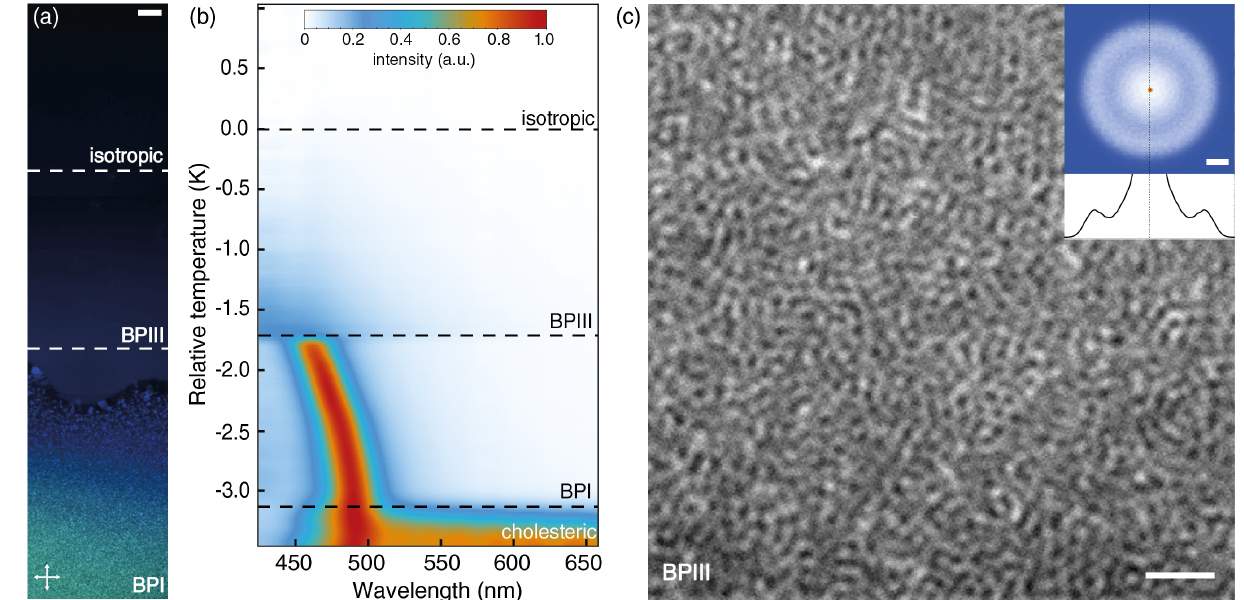
FIG. 4. Reflectivity and appearance of blue phase III of chiral liquid crystals. (a) Photograph of BPIII LC in a capillary with a large temperature gradient, from T ∼ 27 °C at the bottom to T ∼ 30 °C at the top. The scale bar indicates 10 μ m. (b) Spectrum of white light reflected from a 20 - μ m-thick layer of BPIII (see Appendix B). Note the continuous increase of the broad reflectivity spectrum of BPIII as it approaches the BPI. The Bragg reflection band in the BPI indicates long-range crystalline order with a lattice constant of approximately 215 nm. (c) Photograph of BPIII taken in the reflection of green light from an approximately 1 - μ m-thick cell. The dark spots are caused by the arrangement of skyrmion filaments near the surface. The scale bar indicates 1 μ m. The inset is an average FFTof many BPIII images, showing an intensity ring centered at approximately 25 μ m − 1 , which corresponds to an approximately 250-nm separation between the dark spots. The scale bar indicates 10 μ m − 1